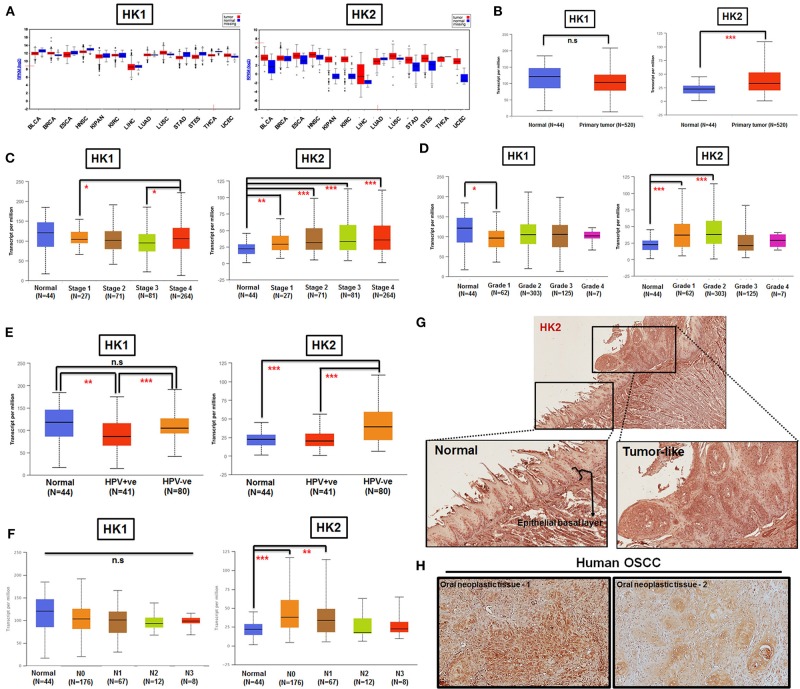
HK2 level positively correlates with HNSCC progression in clinic. (A) HK1, but not HK2, mRNA expression is enriched in most human tumors by using Firebrowser database. BCLA, bladder urothelial carcinoma; BRCA, breast invasive carcinoma; ESCA, esophageal carcinoma; HNSCC, head and neck squamous cell carcinoma; KIPAN, Pan-kidney cohort (KICH+KIRC+KIRP); KIRC, kidney renal clear cell carcinoma; LIHC, liver hepatocellular carcinoma; LUAD, lung adenocarcinoma; LUSC, lung squamous cell carcinoma; STAD, stomach adenocarcinoma; STES, stomach and esophageal carcinoma; THCA, Thyroid carcinoma; UCEC, uterine corpus endometrial carcinoma. (B) Statistical analysis for HK1 and HK2 mRNA levels in normal and primary HNSCC tissues as well as tumor tissues, classified by clinical (C) stages, (D) grade, (E) HPV infection status, and (F) nodal metastasis status from UALCAN database. Immunohistochemical analysis for HK2 in (G) in 12-week 4-NQO–treated mouse tongue and (H) human oral squamous cell carcinoma (hOSCC) tissues. Data are shown as mean ± SEM. ***p < 0.001, **p < 0.01, *p < 0.05, and n.s., non-significant.